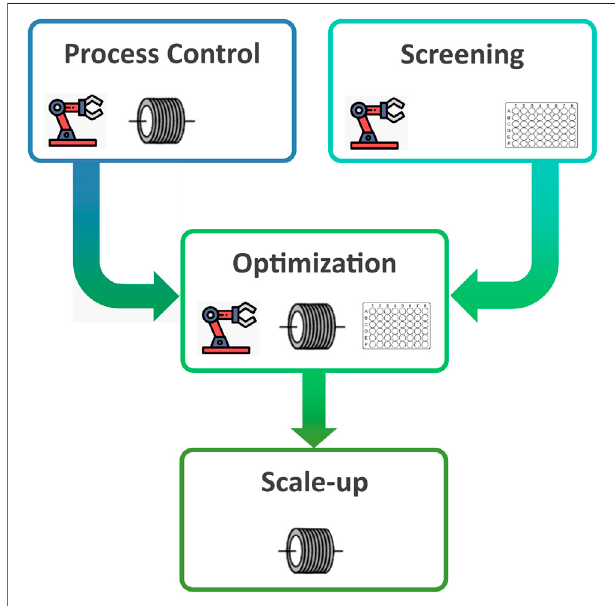
FIGURE 1 | Typical processes involved in supramolecular system discovery and exploitation that can be enhanced using automation, fl ow chemistry, and/or high-throughput